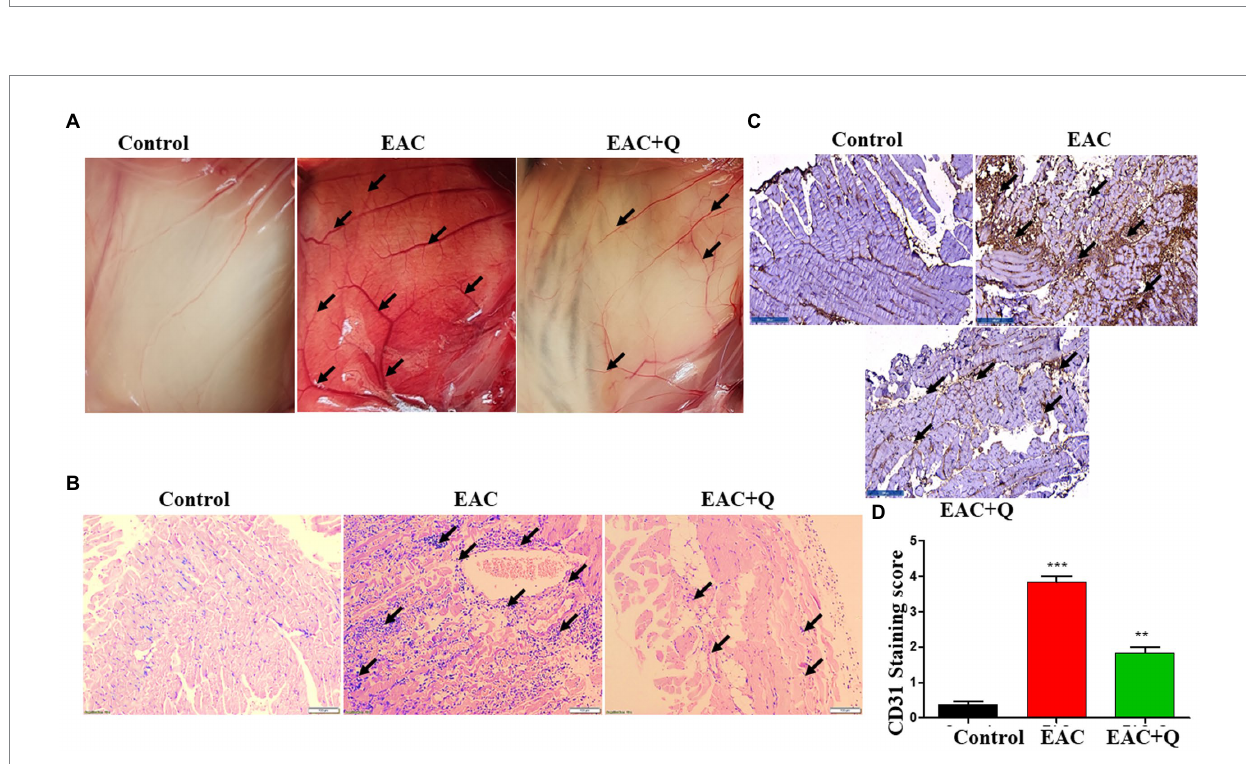
FIGURE 3 Quercetin suppresses the peritoneal angiogenesis via CD31 angiogenic marker. (A) Representative image shows the decreased peritoneal neo- angiogenesis in quercetin treated EAC mice when compared to control EAC bearing mice ( n = 5/group). (B) Representative histopathology images of peritoneum, H&E staining shows the suppression of inflammatory cells infiltration in quercetin treated EAC mice when compared to control EAC bearing mice ( n = 5/group). (C) Immunohistochemistry images represent the decreased expression of CD31 marker in quercetin treated EAC mice when compared to EAC bearing mice ( n = 5/group). (D) Bar graph represent the scoring of CD31 marker in respective groups ( n = 5/group). **, *** represents that p values less than 0.005 and 0.0005